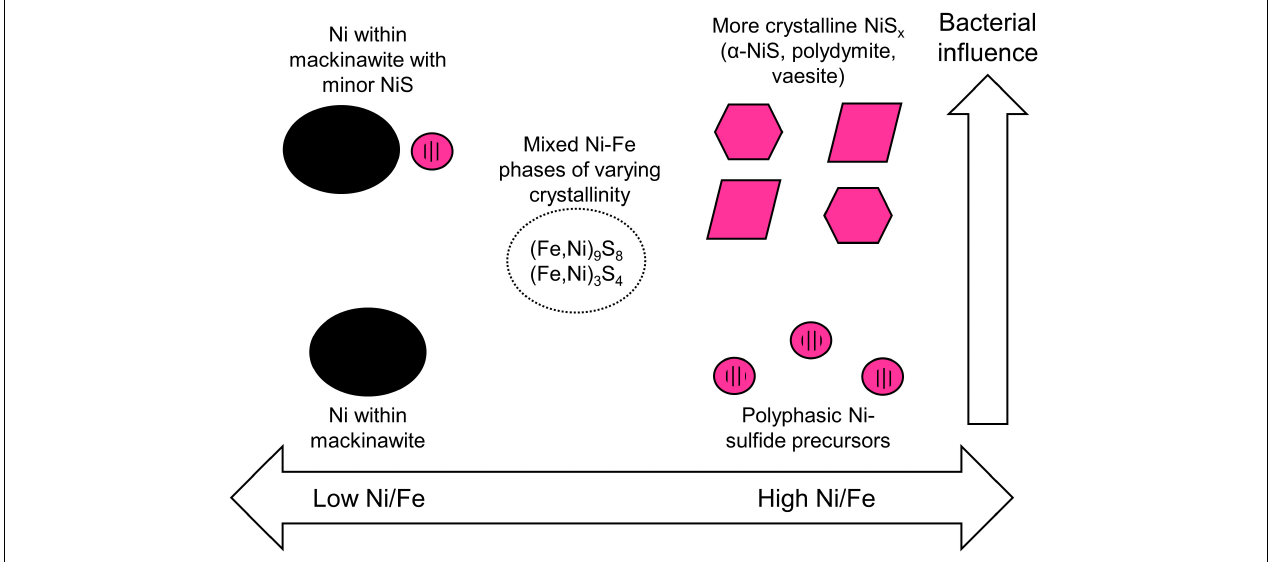
FIGURE 11 | Schematic summary of the predicted Ni-hosting phases in euxinic environments based on the initial [Ni] aq /[Fe] aq ratios in solution and the degree of bacterial influence.